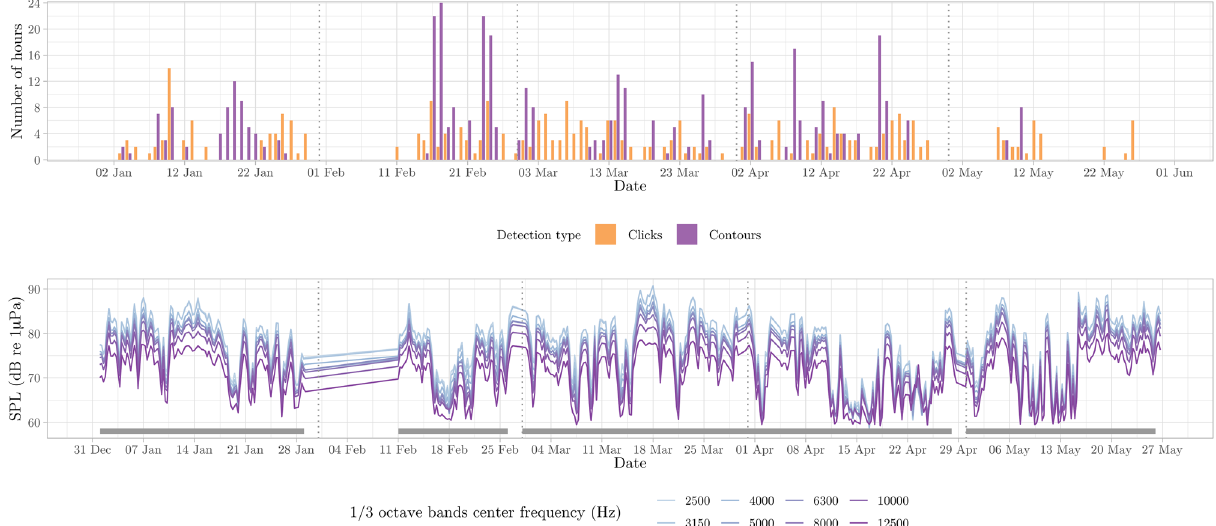
Figure 5. Number of detection hours per day for frequencies above 2 kHz, with detections according to the detector used for clicks, and contours, representing odontocete clicks and high frequency whistles (top). Sound Pressure Level values for different 1/3 octave bands, grouped into six-hour averages for visibility purposes (bottom). Grey segment bars indicate the sampling effort in days (i.e., gaps represent lack of acoustic